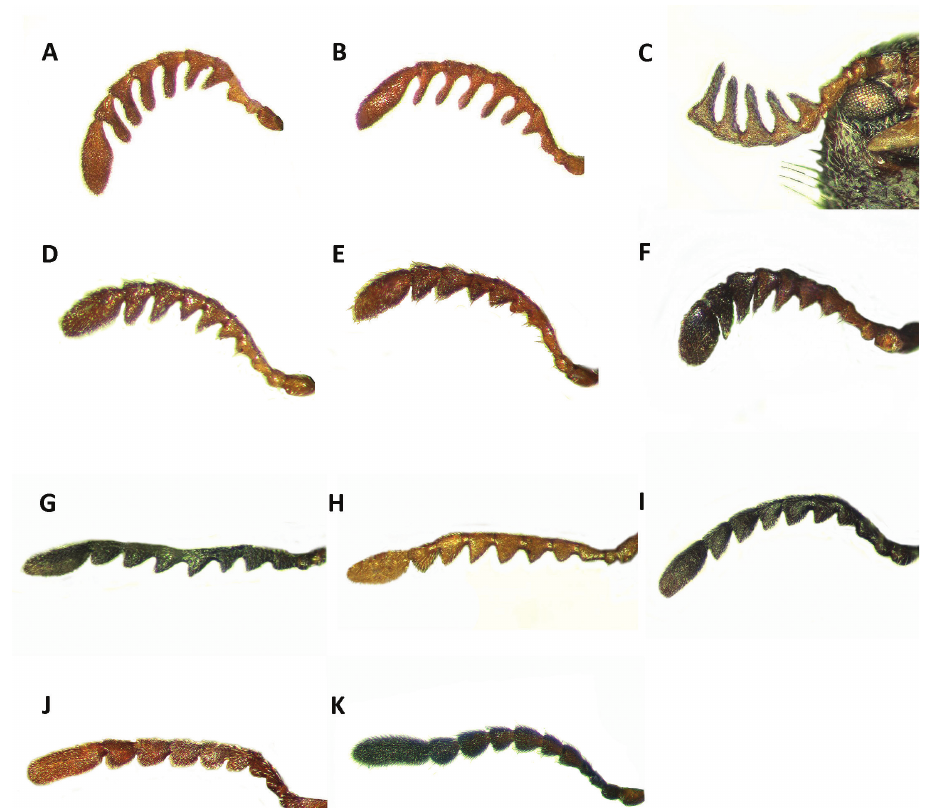
Figure 3. Antennae of: A Neocallotillus elegans ( Callotillus elegans elegans ) male B N. elegans ( C. e. vafer ) male C N. intricatus ( C. intricatus ) male holotype D Neocallotillus elegans ( C. e. elegans ) female E N. elegans ( C. e. vafer ) female F N. intricatus ( C. intricatus ) female G Callotillus bahamensis male H C. eburneocinctus male I C. bahamensis female J C. eburneocinctus female K Barrotillus kropotkini male. Acacia greggii , G. H. Nelson; 1 male, 2 females: Baja Calif. S., Mex., La Paz,